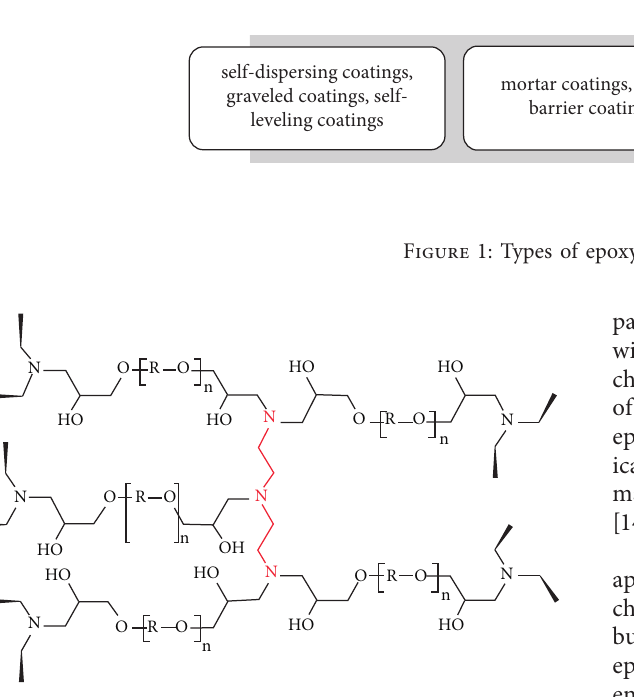
Figure 2: Chemical formulas and chain polymer chain diagrams of